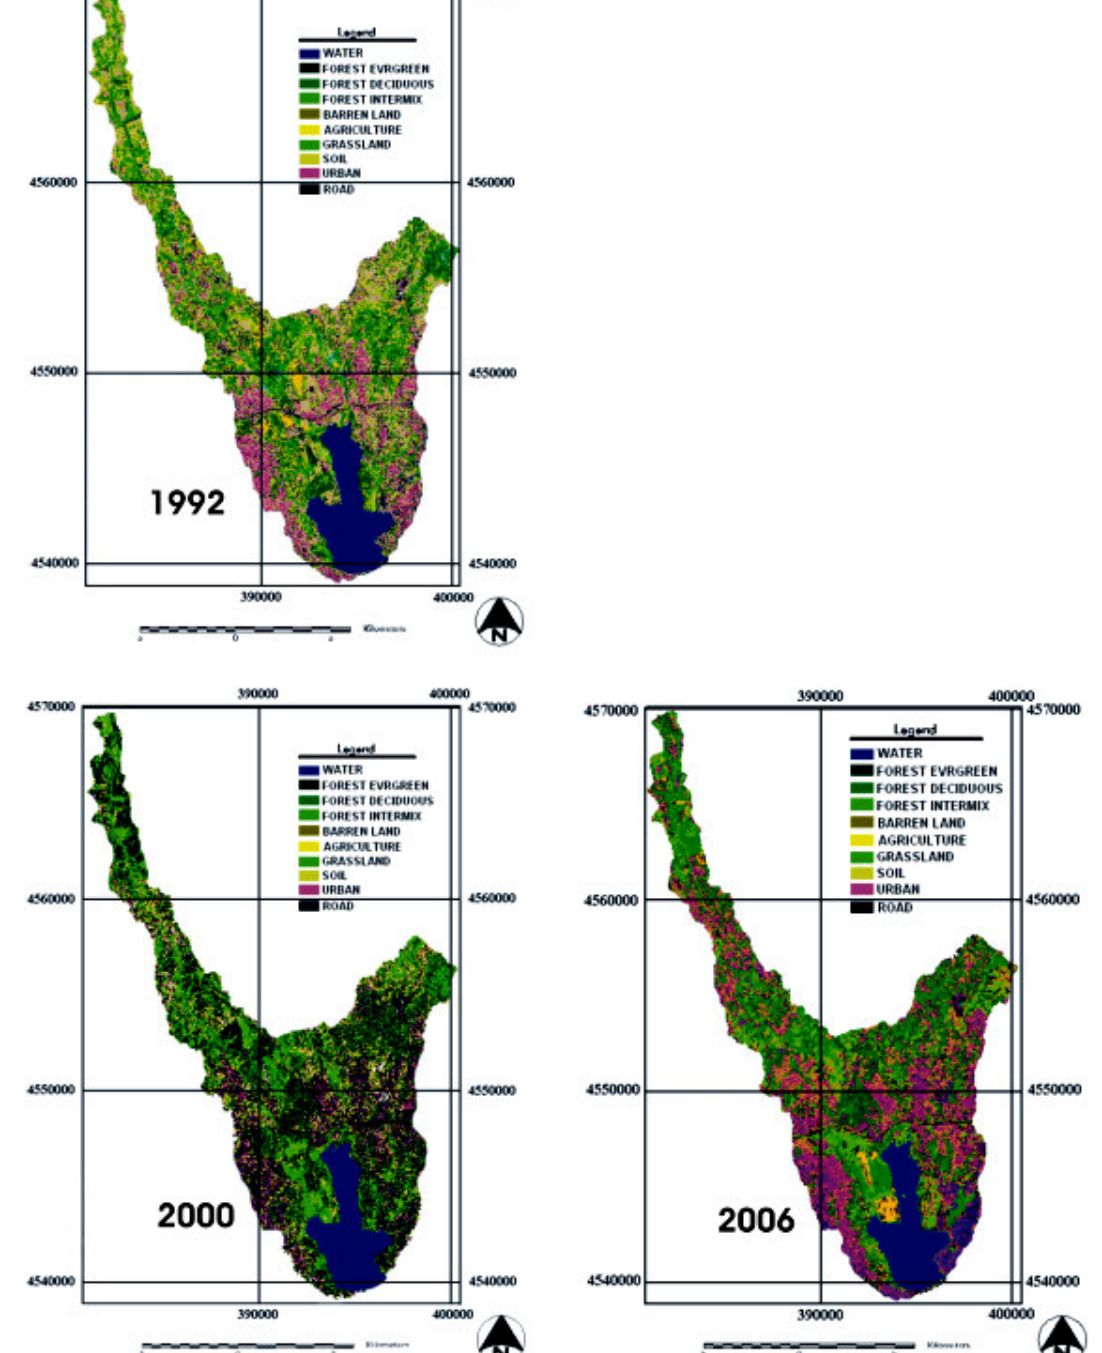
FIGURE 3 . Classified images of the Küçükçekmece Water Basin dated 1992, 2000, and